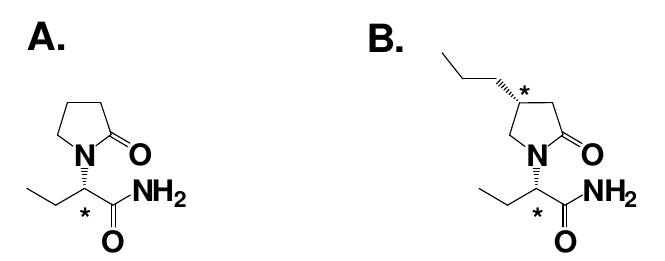
Figure 5. A. Levetiracetam; B. Brivaracetam. Asterisk denotes a chiral